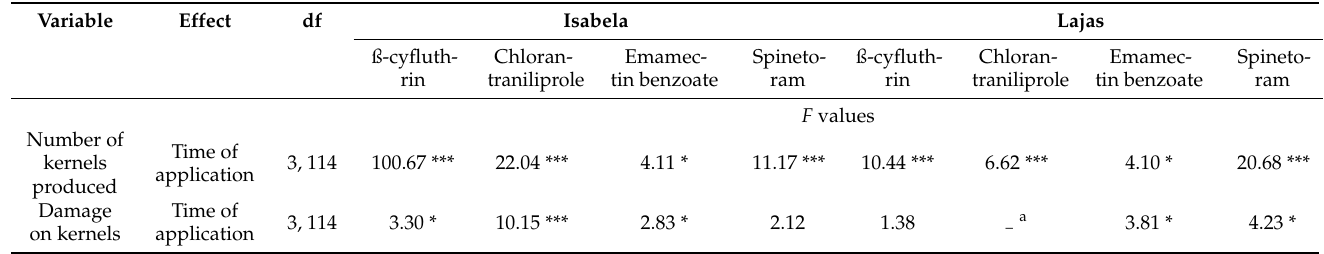
Table 3. Simple analysis of variance for the number of kernels produced and percentages of damage of corn earworm ( Helicoverpa zea (Boddie) (Lepidoptera: Noctuidae)) and fall armyworm ( Spodoptera frugiperda (J. E. Smith) (Lepidoptera: Noctuidae)) per each insecticide in sweet corn ( Zea mays